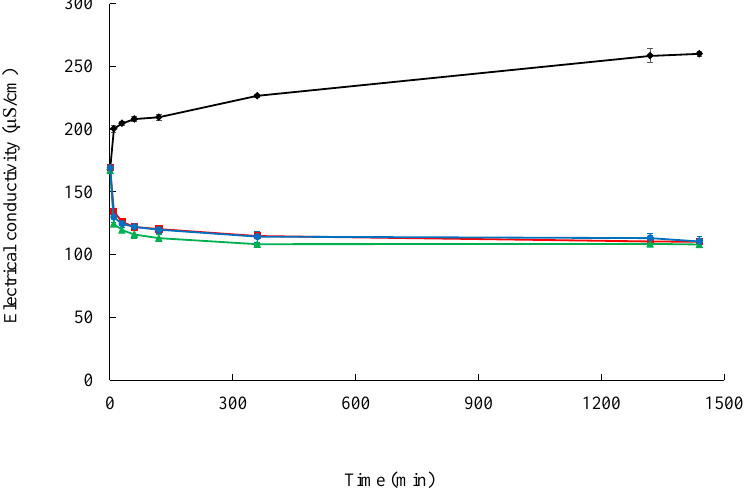
(cid:4) 5-SN, (cid:78) 5-NP, •